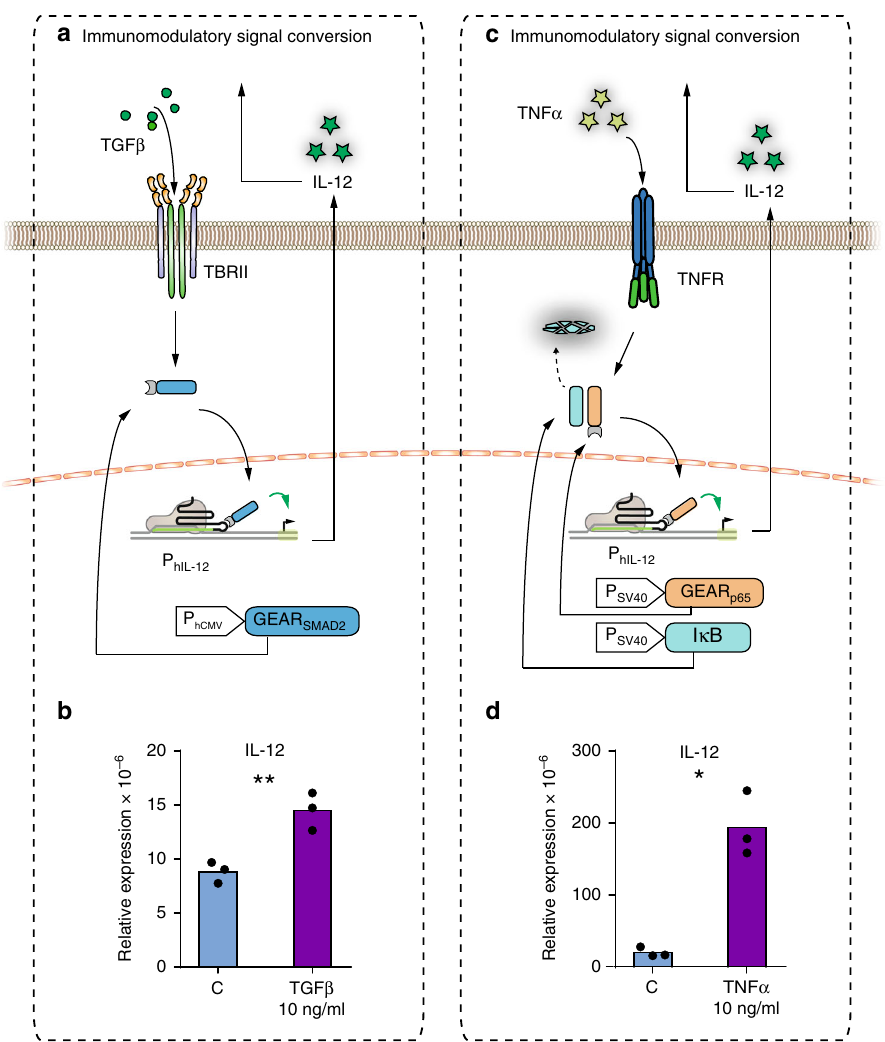
Fig. 5 Rewiring in fl ammation-related signaling pathways to genomic targets. a Immunomodulatory signal conversion. TGF β -induced TBRII activation causes nuclear translocation of GEAR SMAD2 and subsequent IL-12 promoter (P hIL-12 ) activation. b At 24 h after the beginning of transfection, HEK293T cells expressing dCas9, GEAR SMAD2 , TBRII, and a human IL-12B promoter-speci fi c sgRNA were stimulated with 10 ng/mL TGF β . IL-12B mRNA was quanti fi ed after 36 h. c Immunomodulatory signal switch. TNF α -induced TNFR activation causes I κ B degradation, resulting in nuclear translocation of GEAR p65 and IL-12 promoter (P hIL-12 ) activation. d At 24 h after the beginning of transfection, HEK293T cells expressing dCas9, GEAR p65 , I κ B, and a human IL-12B promoter-speci fi c sgRNA were stimulated with 10 ng/mL TNF α . IL-12B mRNA was quanti fi ed after 36 h. Violet bars represent mRNA expression (relative to GAPDH) in stimulated cells (mean value). Blue bars represent mRNA expression in controls without inducer. Black dots correspond to individual data points of n = 3 biological replicates. * p < 0.05, ** p < 0.01. Statistical signi fi cance was calculated using a two-tailed t -test. A detailed description of the statistical analysis is provided in Supplementary Table 5. Source data are provided as a Source Data fi